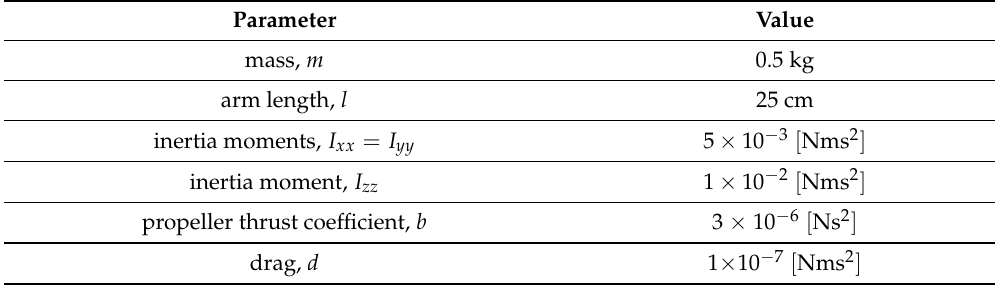
Table 2. Quadrotor structural and dynamic parameters.